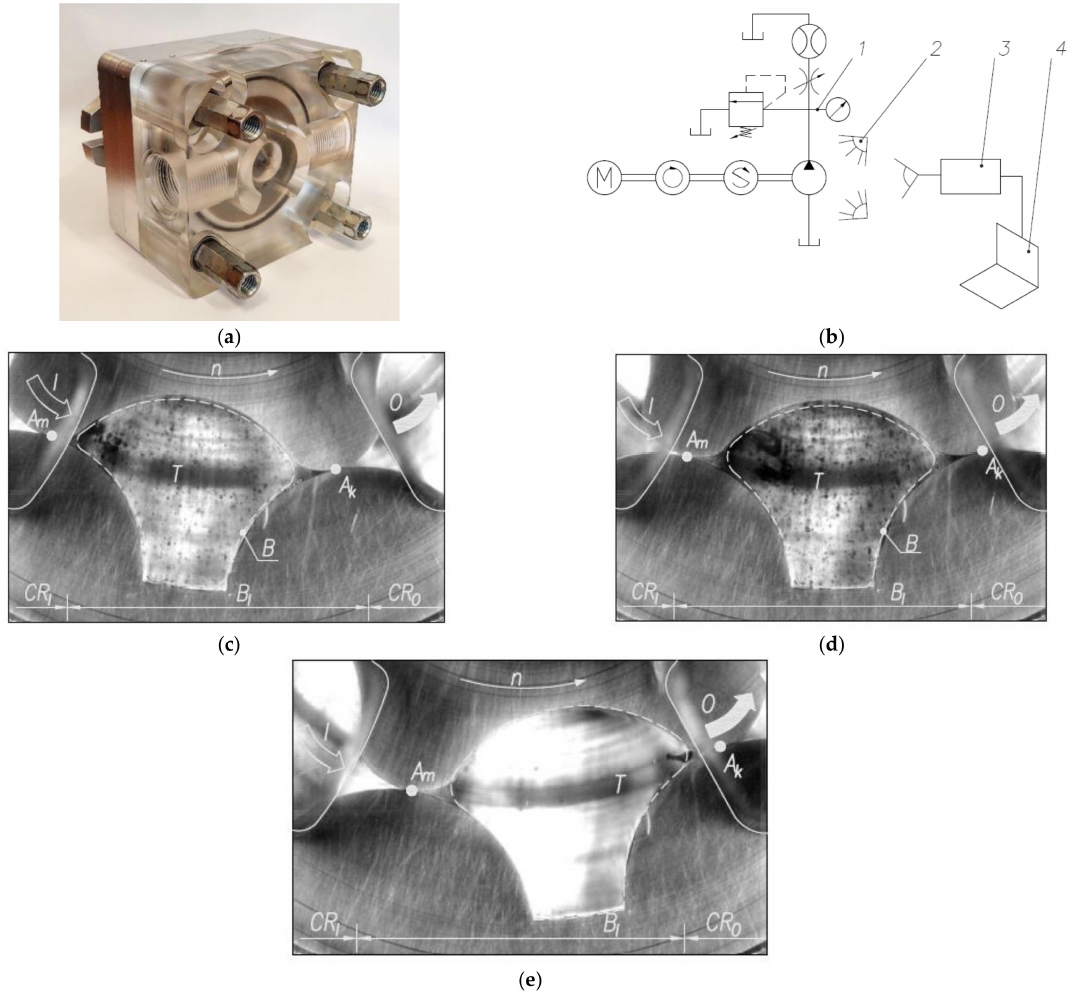
Figure 18. Visualization study using the PIV method: ( a ) experimental gerotor pump; ( b ) examination stand (1-hydraulic system; 2—illuminative system; 3—high speed camera; 4—computer); ( c – e ) view of the flows through inlet bridge B , ( ρ JO ) cooperating with displacement chamber ( T